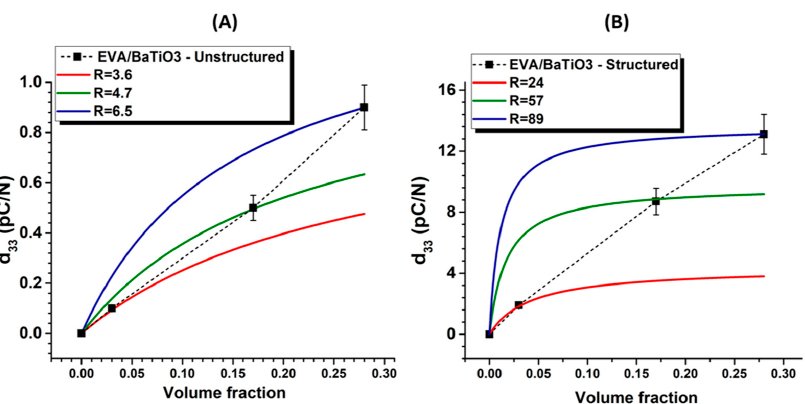
Figure 9 . Fitting with Van den Ende’s model for ( A ) EVA/BaTiO 3 unstructured composites, ( B ) EVA/BaTiO 3 composites structured at E = 6 kV.mm – 1 .